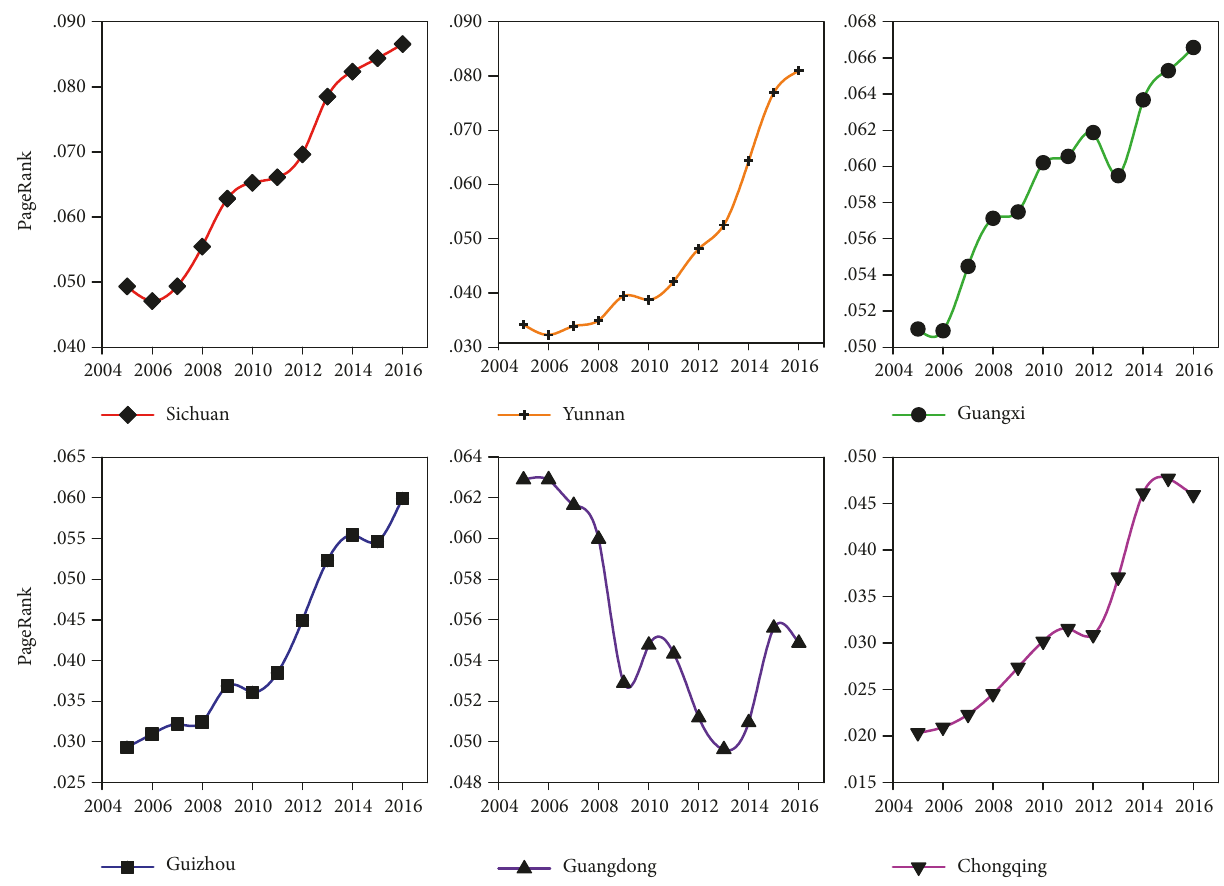
Figure 5: Top-ranked provinces in 2005-2016 based on